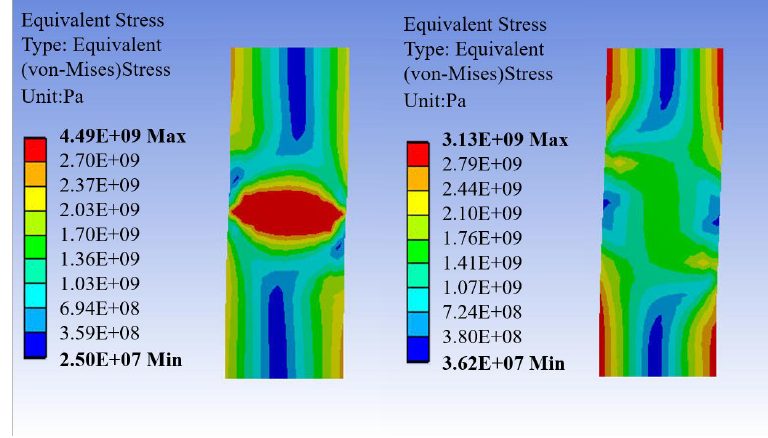
Figure 20. Stress analysis for comparison of the screws (equivalent stress).